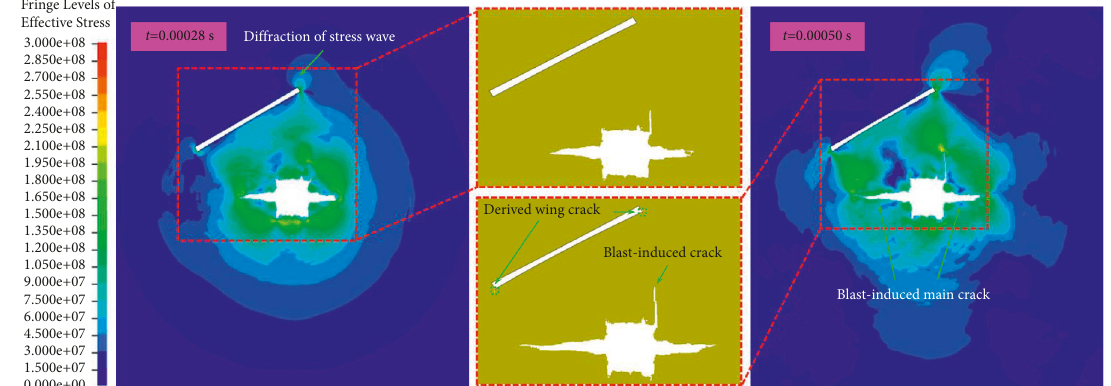
Figure 6: Pressure diagram of explosion stress wave transmission for case CN